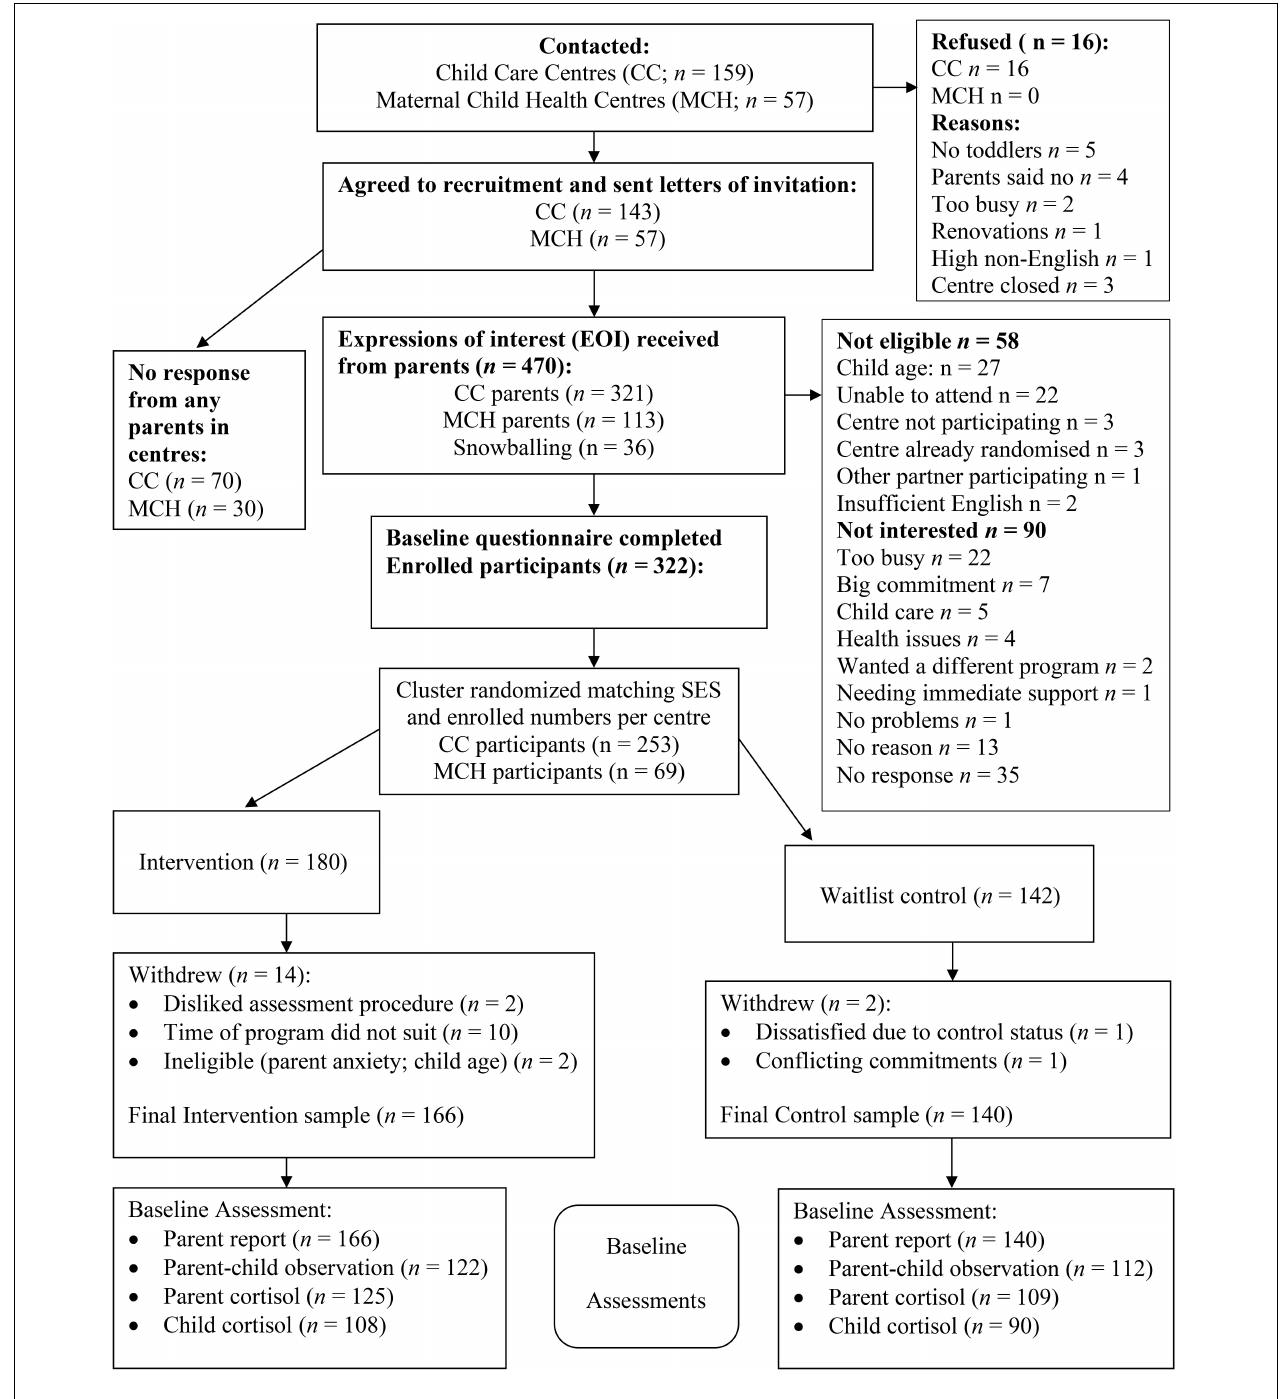
FIGURE 1 | Recruitment